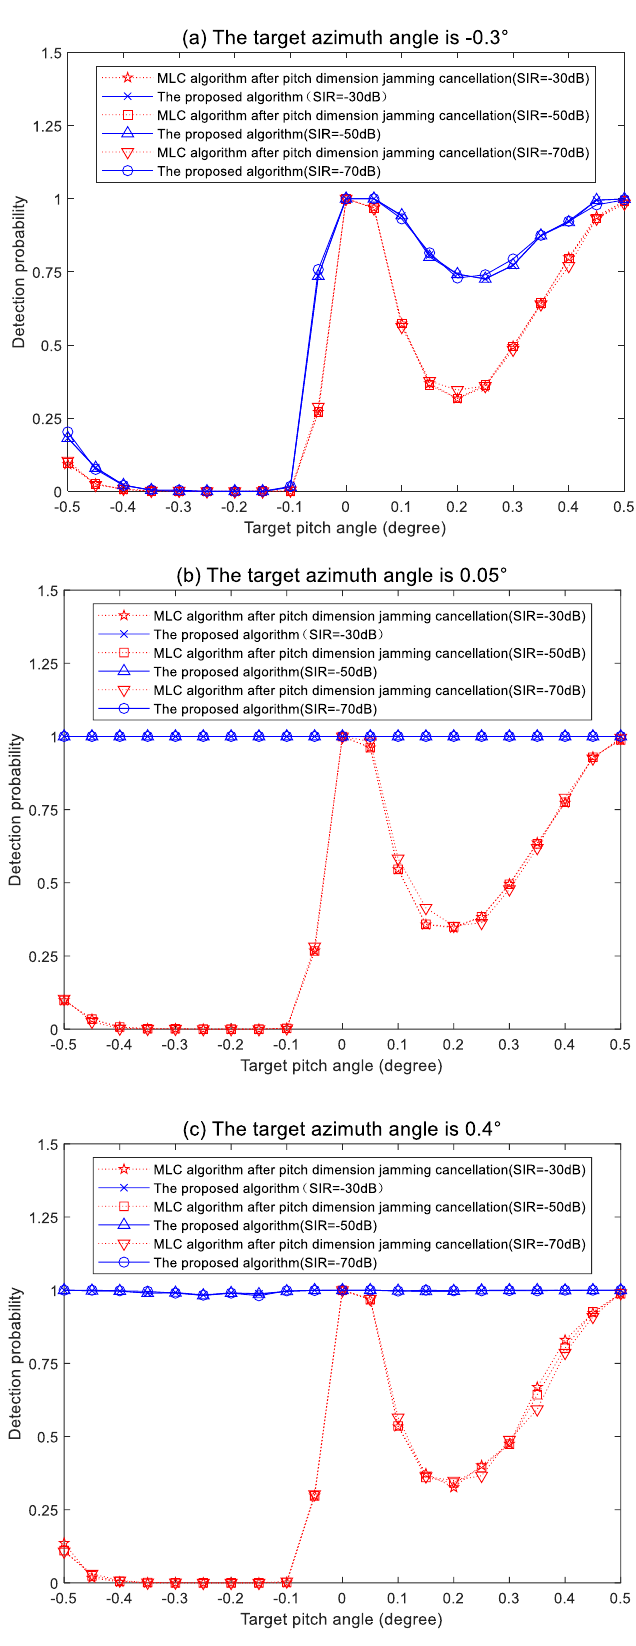
Figure 7. The detection performance of the two algorithms.